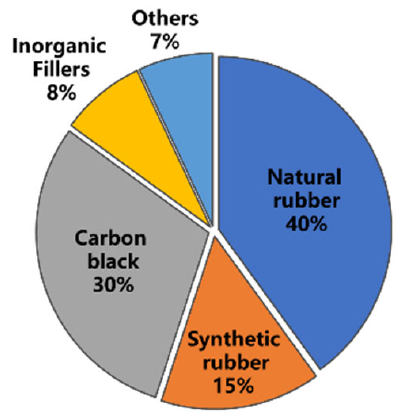
Figure 2. The composition of the GTR from truck tire [16].